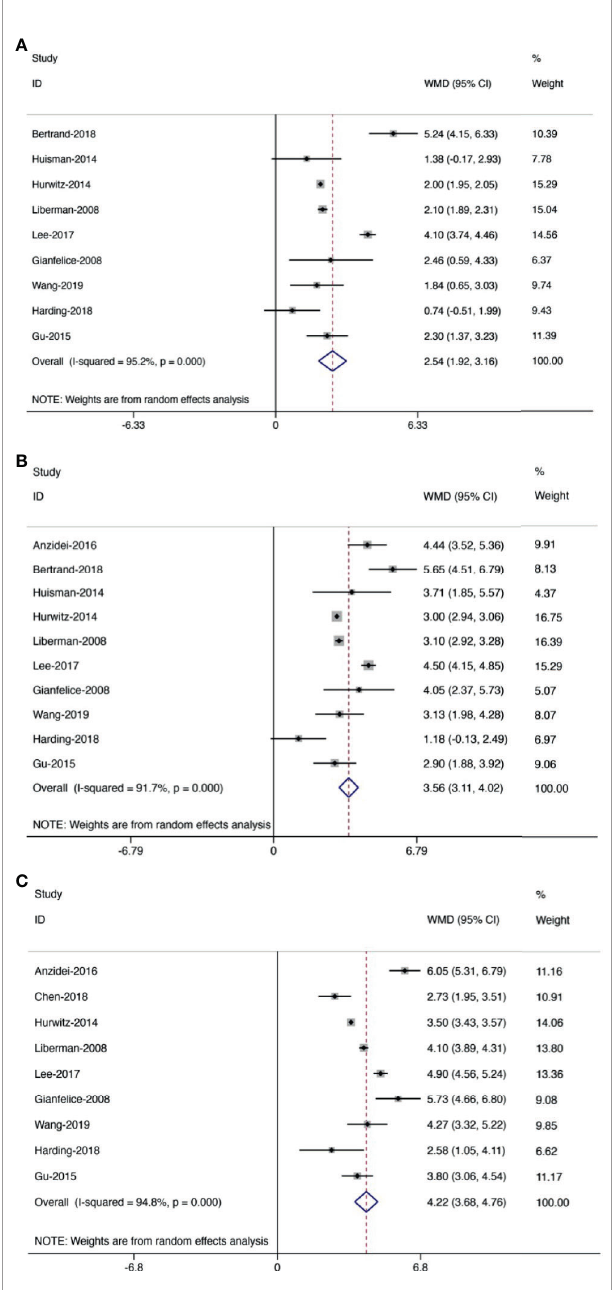
FIGURE 5 | Forest plot for inclusion of all included studies assessing pain improvement at different time points compared with baseline; diamonds represent overall pain scores for random and fi xed effect models with 95% CI. Meta-analysis of pain improvement at different time points. (A) At 0 – 1 week. (B) At 1 – 5 weeks. (C) At 5 – 14